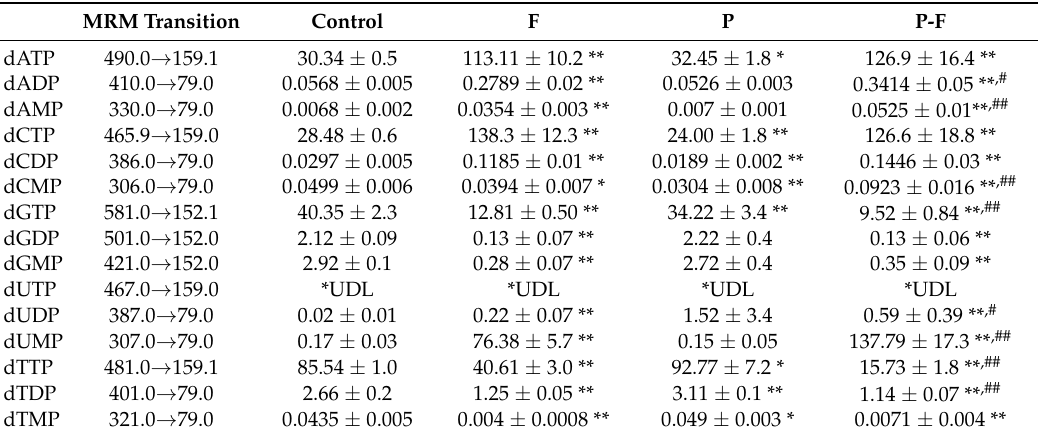
Table 3. Levels of dRNs in HepG2 cells of every group (pmol/10 6